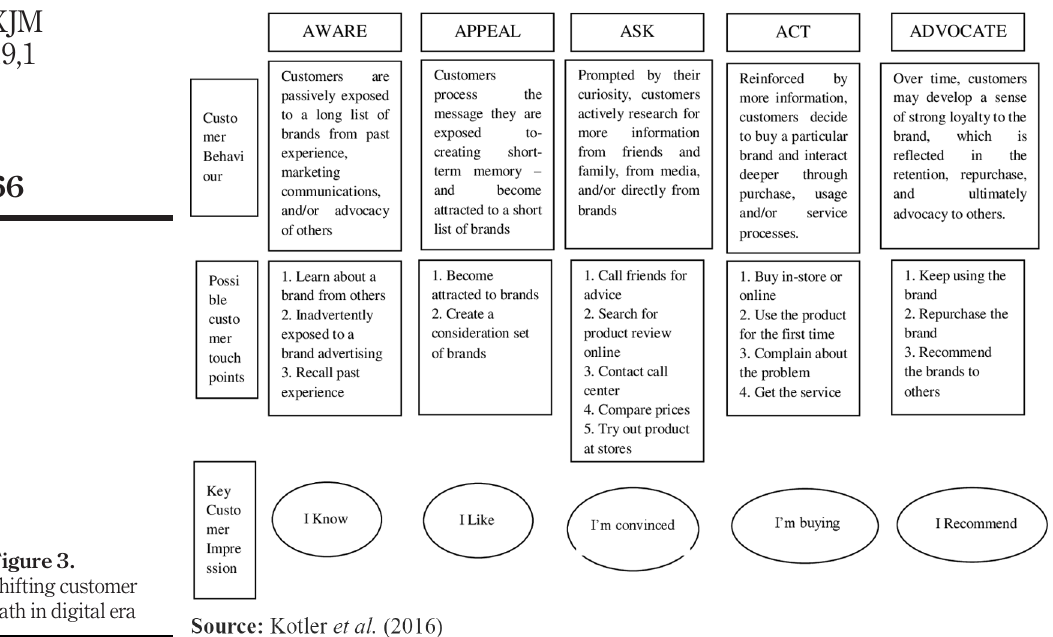
Figure 3. Shifting customer path in digital era